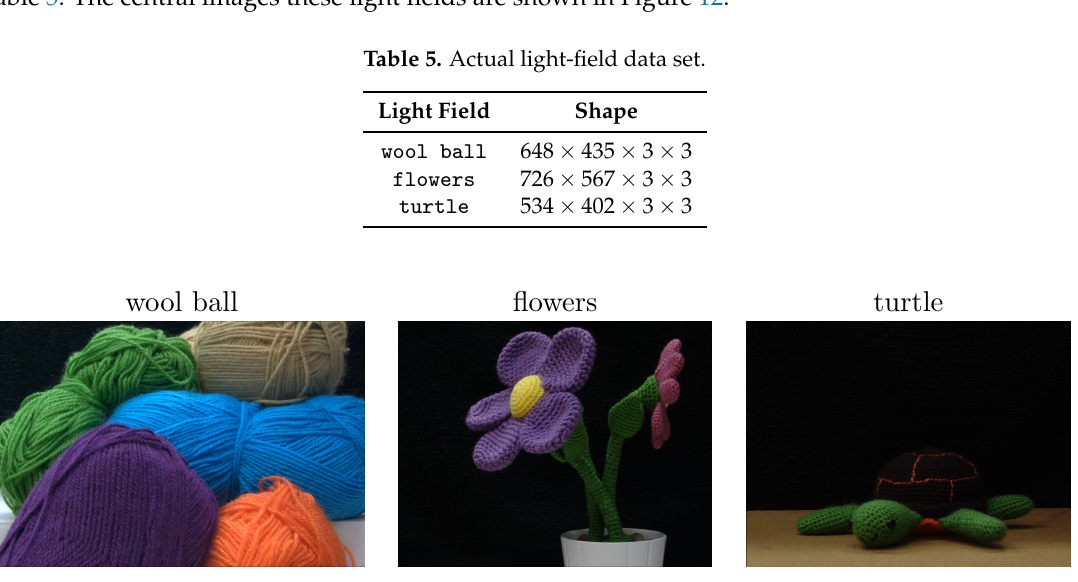
Figure 12. Central images of actual test light fields.